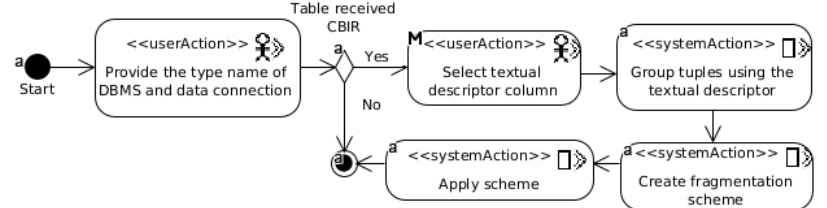
Figure 1. Static fragmentation method workflow contemplating CBIR.